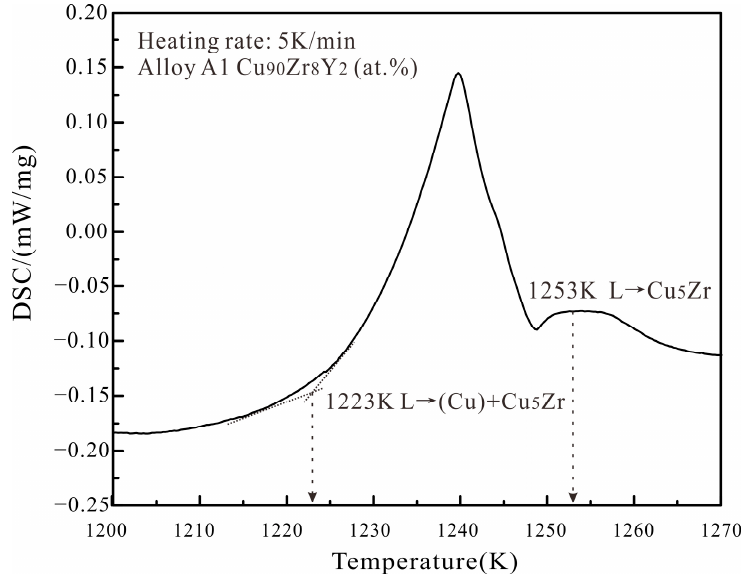
Figure 5. The DSC curves with a heating rate of 5 K/min for annealed alloy A1 Cu 90 Zr 8 Y 2 (at.%) of the Cu–Zr–Y